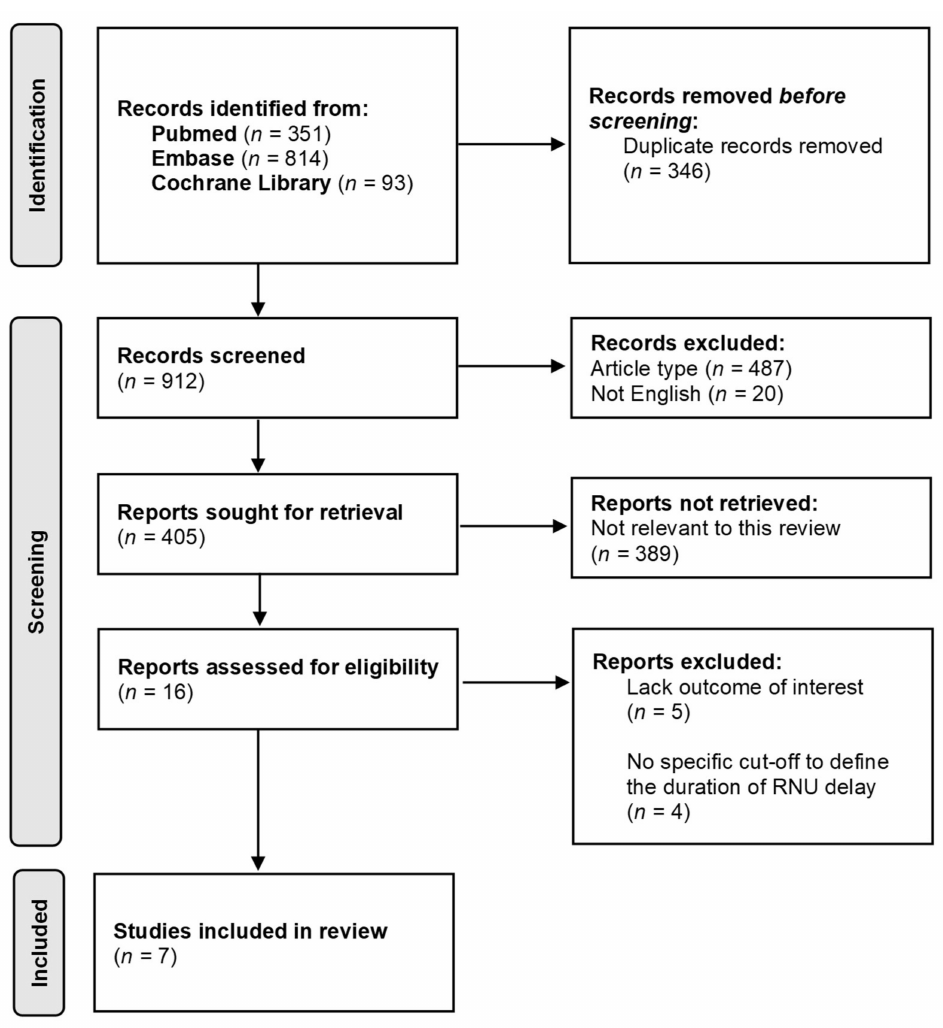
Figure 1. A PRISMA flowchart describing the study selection process. RNU = radical